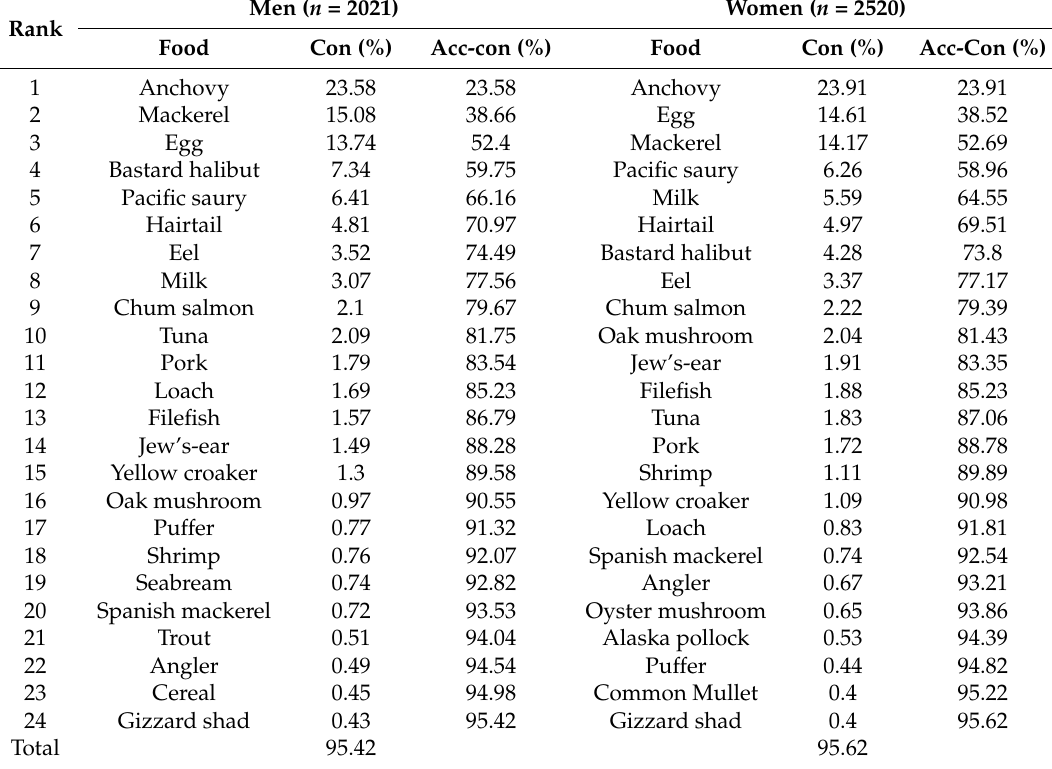
Table 5. Daily and accumulated contribution of vitamin D-rich foods in Korean